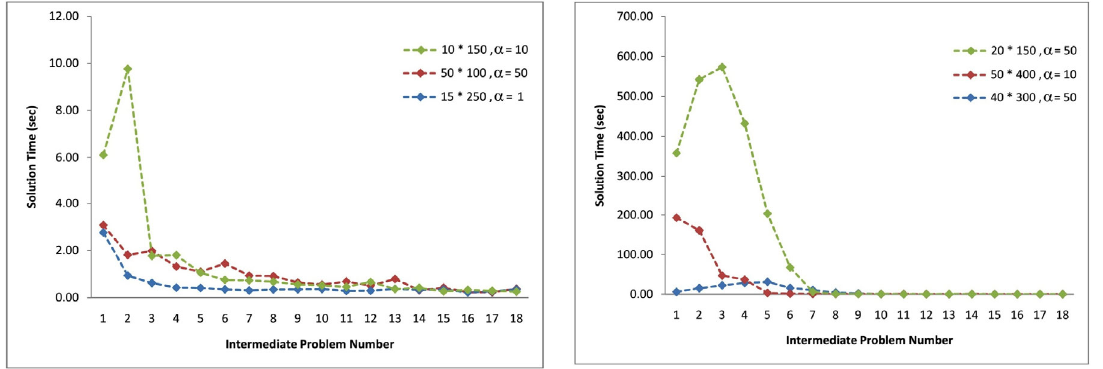
Fig. 3 . The average solution times of the intermediate problems in Table 7 for some problem